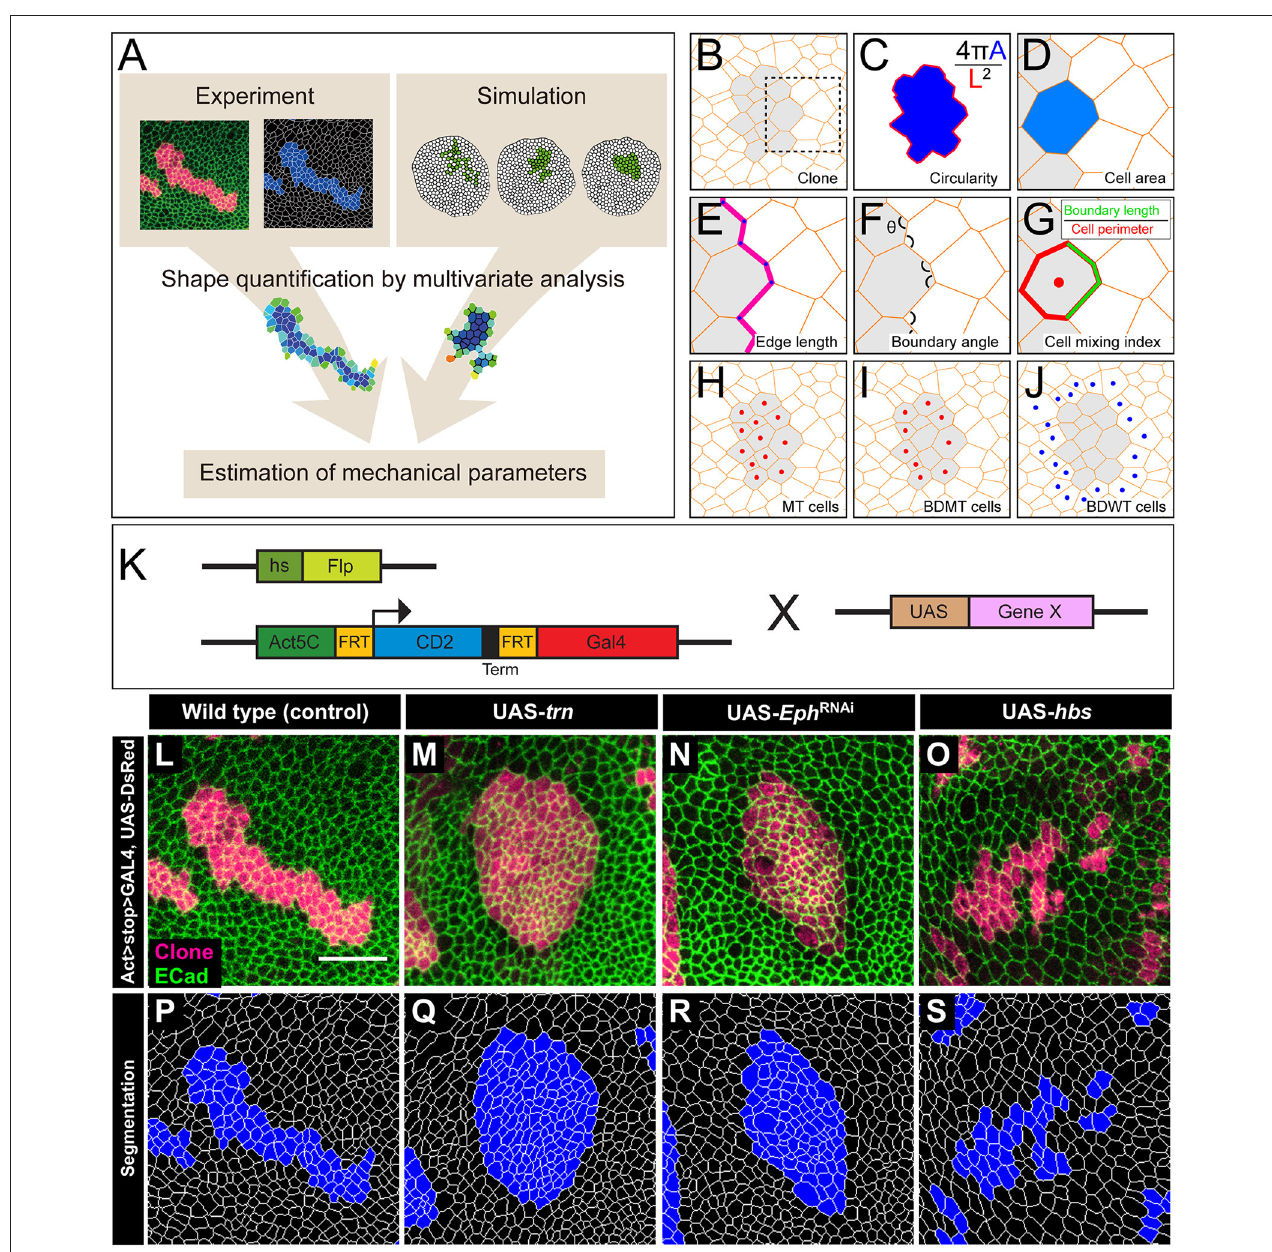
FIGURE 1 | The multivariate estimation pipeline using quantitative evaluation of clone shape. (A) Schematic summary of the inference procedure. (B–J) Criteria used for the evaluation of clone shape. Circularity (C) was measured only for closed clones, while the other six cell-based criteria (D–J) were measured for both closed clones and open clones. The cell-based criteria (D–J) were calculated for each edge, tri-cellular junction, or cell, and the values were averaged over each clone. (B) Scheme for a clone. Orange lines represent adherens junctions, and cells within a clone are shaded. (C) Circularity calculated as 4 π A/(L 2 ), where “A” represents the area of the clone, and “L” is the perimeter length of the clonal interface. The circularity of a perfect circle should be 1. (D–G) Magnified images of the box in (B) . (D) Area of a cell within a clone normalized by that of all wild-type cells surrounding the clone in a disc. (E) Length of edges (cell junctions between neighboring vertices) at the clone boundary normalized by that of edges between wild-type cells. (F) Boundary angle, which is the smaller angle ( < 180 ◦ ) between neighboring junctions along the clone boundary at every tri-cellular junction (three-way vertices). (G) Cell mixing index, which is the fraction of the perimeter of a cell that is shared with cells from the other side of the clone boundary. (H–J) The cells used to calculate the average cell mixing index for MT, BDMT, and BDWT are marked by red dots in ( H , all cells within the clone) (I , clonal cells beside the clone boundary) and blue dots in (J , wild-type cells beside the clone boundary), respectively. (K) Scheme for genetic manipulation used to generate the clones. GAL4 is expressed only when the CD2 cassette, which includes a transcription termination sequence and is flanked by FRT sites, is excised upon Flippase (Flp) induction by heat shock. Once expressed, GAL4 binds to the UAS sequence and drives expression of the downstream gene. (L–O) Clones expressing a marker for wild-type (L) , trn (M) , double-strand RNA against Eph (N) , and hbs (O) . (P–S) Segmentation of the cell junctions in (L–O) .